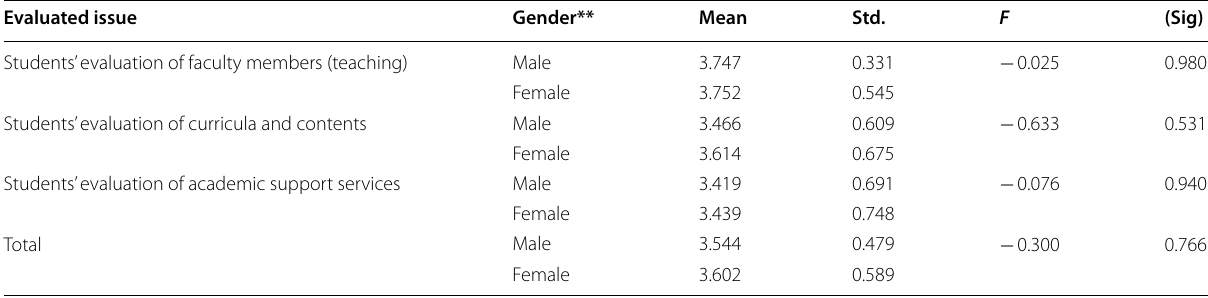
Table 3 Means, standard deviations, one-way ANOVA analysis of students’ evaluation of the FS program at the Al-Istiqlal University according to